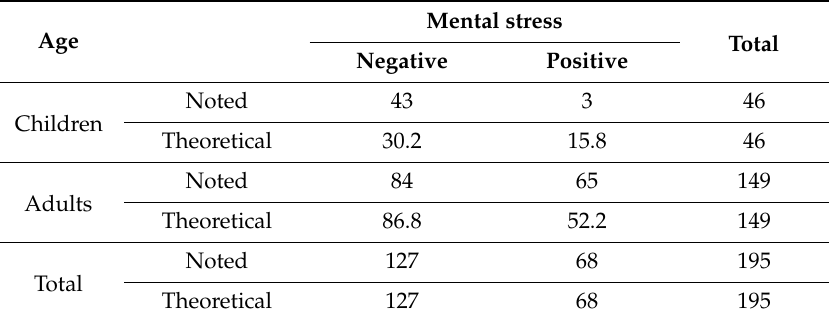
Table 8. Contingency table of correlation between age and mental stress.